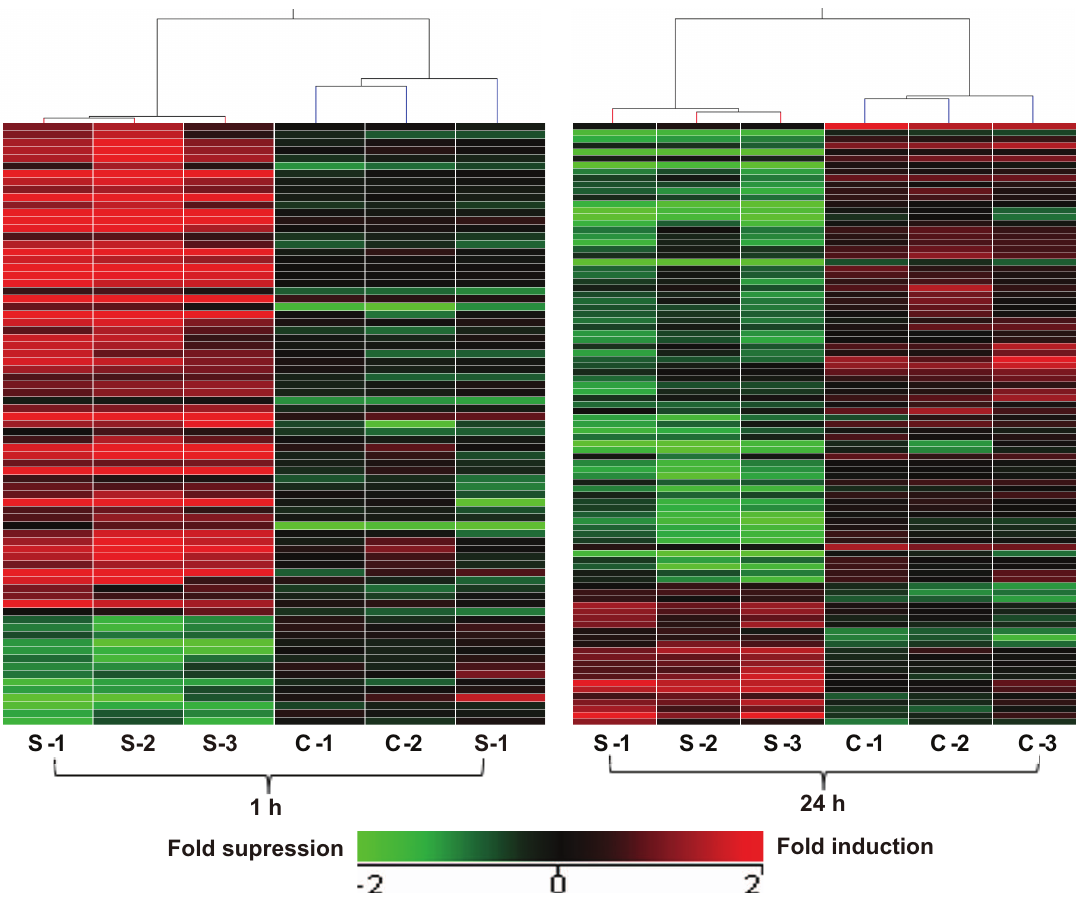
Figure 1. Hierarchical cluster analysis of differentially expressed genes (p , 0.05, more than twofold change) at 1 and 24 h. Each row represents a probe and each column represents one sample. The values represent the fold changes compared with the corresponding control. Positive and negative fold changes are shown in red and green, respectively, as shown in the color bar. S, stretching group; C, control group. doi:10.1371/journal.pone.0063467.g001 PLOS ONE |